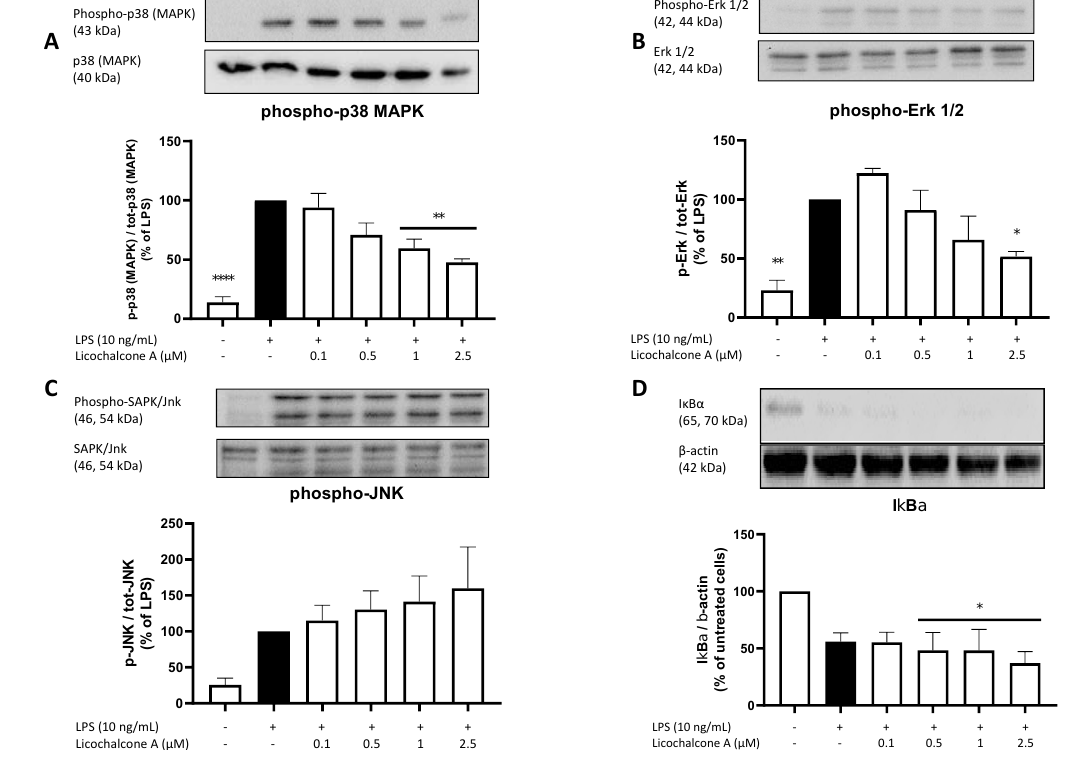
Figure 7. Effects of Licochalcone A on phospho-p38 MAPK ( A ), phospho-Erk 1/2 ( B ), phospho-JNK ( C ), and IκBα ( D ) in LPS-stimulated primary rat microglial cells. Cells were stimulated and Western blots performed as described under materials and methods. Values are presented as the mean ± SEM of at least three independent experiments. Statistical analysis was performed using one-way ANOVA with Dunnett’s post hoc tests wit h * p < 0.05, ** p < 0.01, and **** p < 0.0001 compared to LPS stimulated ( A – C ) or untreated ( D ) cells.